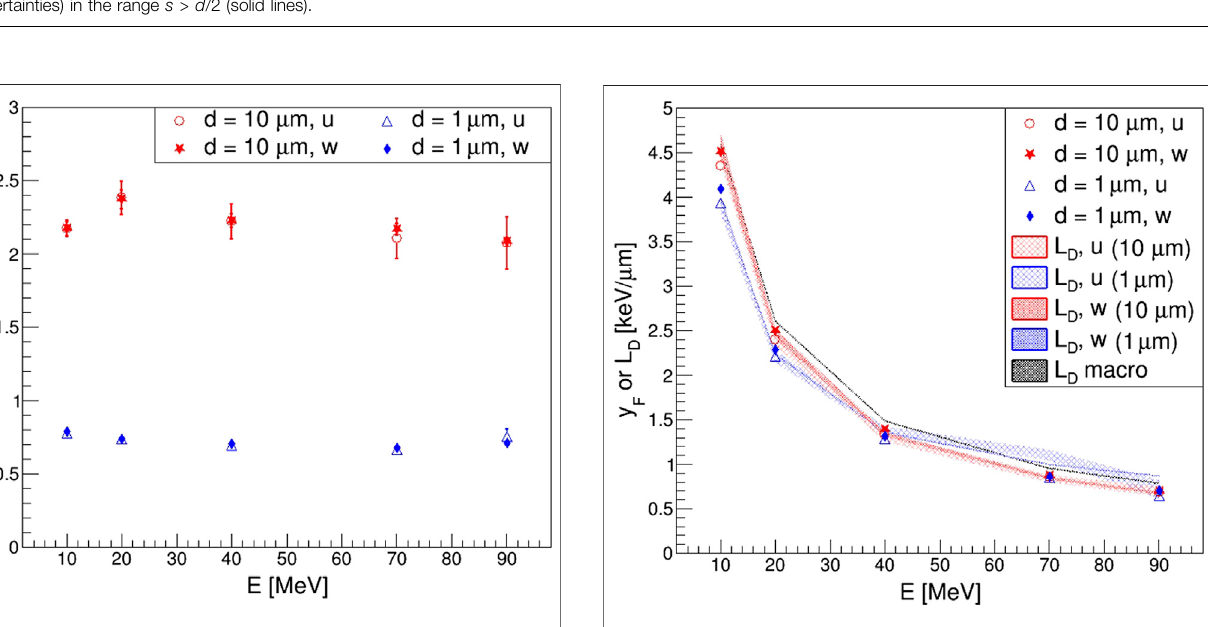
FIGURE 8 | Frequency-averaged lineal energy (cid:1) y F as a function of the incidentprotonkineticenergy.Valuesobtainedforuniform(openmarkers)and weighted (full markers) random sampling methods are compared for sites of1 (blue triangles and diamonds) and 10 μ m (red circles and stars) diameter. For mono-energetic proton beams the relation (cid:1) L D (cid:2) (cid:1) y F should hold, therefore (cid:1) y F valuesareheresuperimposed totherespective (cid:1) L D valuesderived from Eq. 12 , represented as shaded areas whose thickness is given by the error associated to (cid:1) L D for each diameter site. Finally, the macroscopic unrestricted (cid:1) L D computed with Eq. 13 is also reported as a